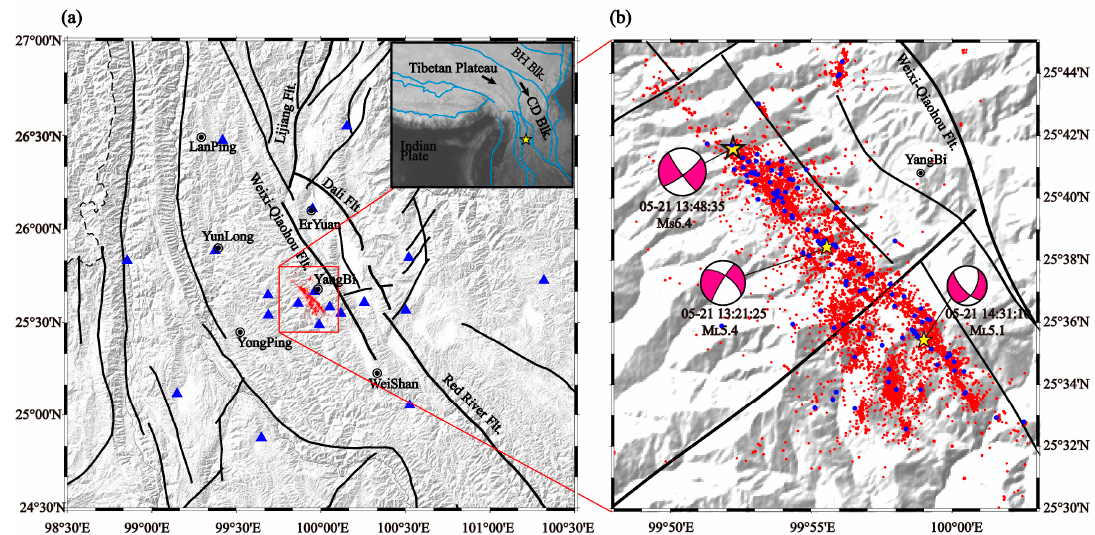
Figure 2. Seismic stations, faults, and epicenters of the Yangbi earthquake sequence. ( a ) The tectonic setting of the Yangbi earthquake. Black lines indicate faults [58], blue triangles indicate seismic stations, and red dots represent the epicenters of the sequence. The blue line in the inset indicates the boundary of the active block, and the yellow five-pointed star indicates the mainshock. ( b ) The distribution of the Yangbi earthquake sequence (red dots), the epicenters of 112 earthquakes used for focal mechanism inversion (blue dots), and the focal mechanism solutions of large earthquakes.